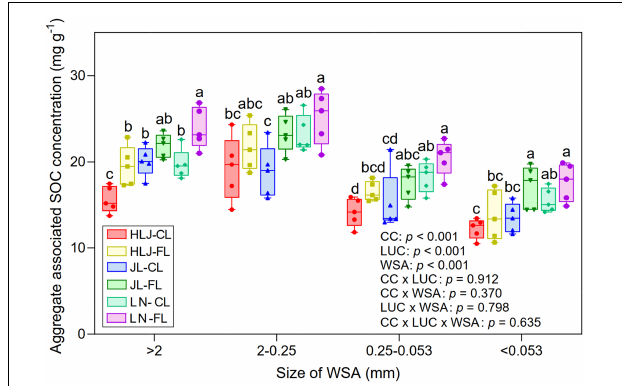
FIGURE 7 | Aggregate-associated soil organic carbon (SOC) concentration (mg g − 1 ) in different sizes of soil water stable aggregates under CC and LUC treatments. CL, cropland; FL, fallow land. The different letters above the error bars for the same aggregate fraction indicate significant differences at p <